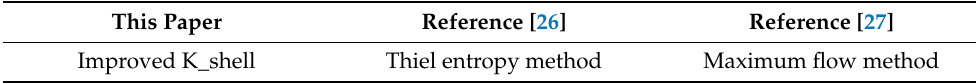
Table 1. Method Comparison.